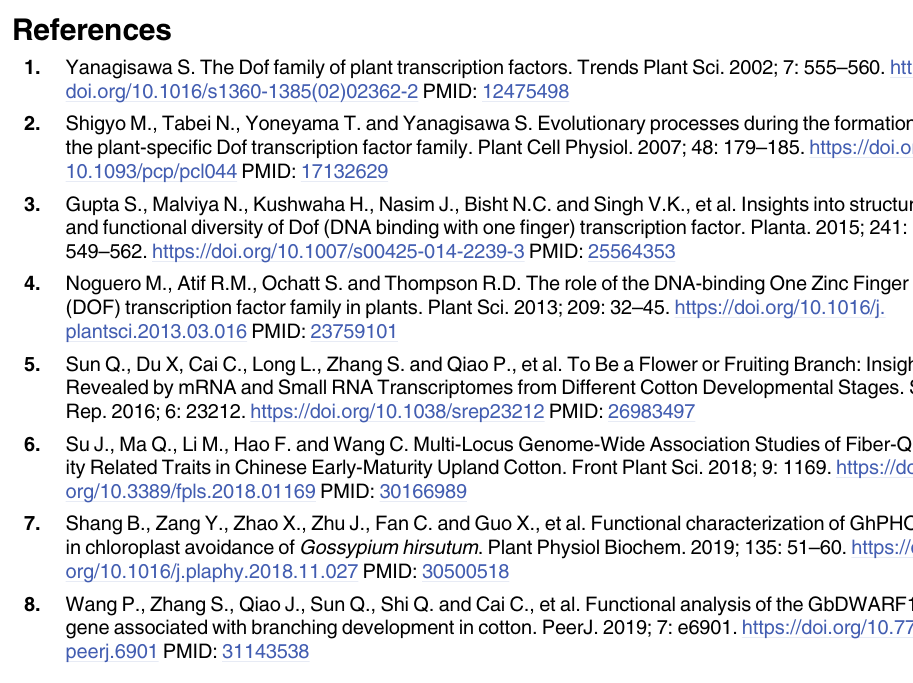
S3 Fig. Chromosomal locations of cotton Dof genes. S4 Fig. The chromosomal distribution and interchromosomal relationships of cotton Dof genes. The lines indicate duplicated Dof